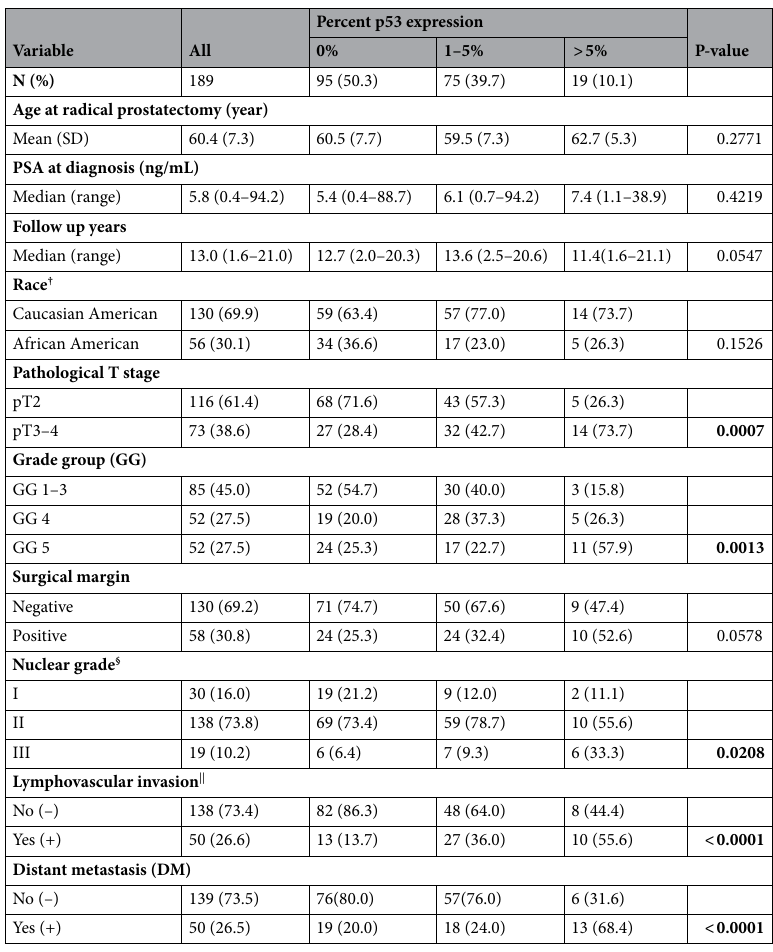
Table 1. Patient demographic and clinico-pathologic features distributed across categories of percent p53 expression (N = 189). Significant values (P-value < 0.05) are in bold. † Three subjects who were neither Caucasian nor African American race were excluded. § Two missing subject data due to treatment effect. || One missing subject data due to capsular incision on whole-mount specimen; appropriate staging not